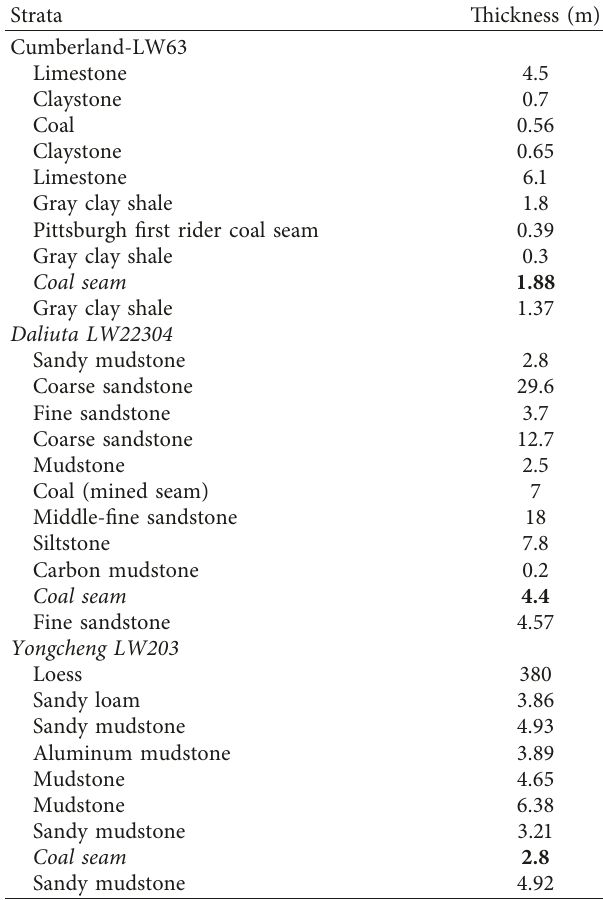
Table 2: Stratigraphic sequence of study